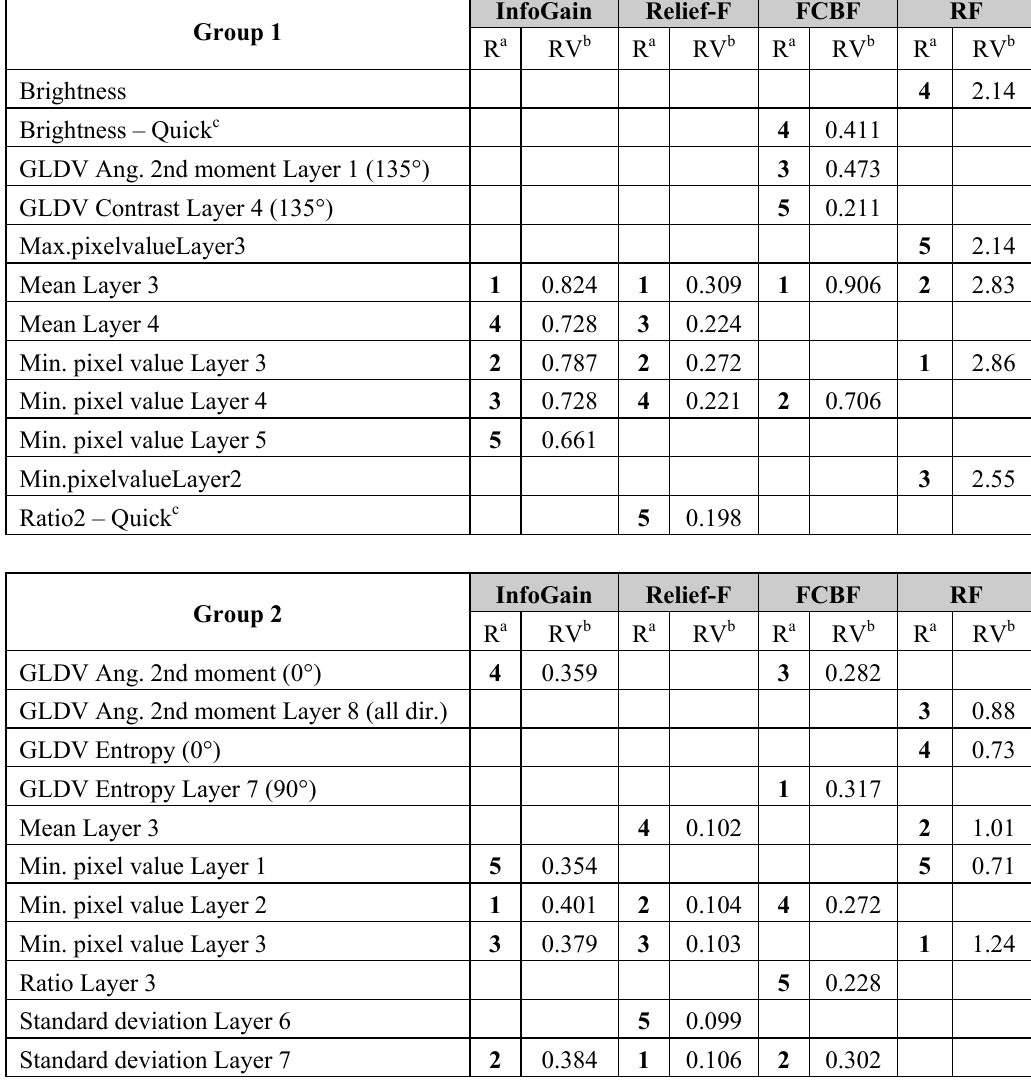
Table 3. Results of the analysis from feature selection. R a stands for the ranking position of the feature and RV b for the relevance value of the concerned feature. Quick c indicates a band math feature calculated with only those bands also available in the QB-2